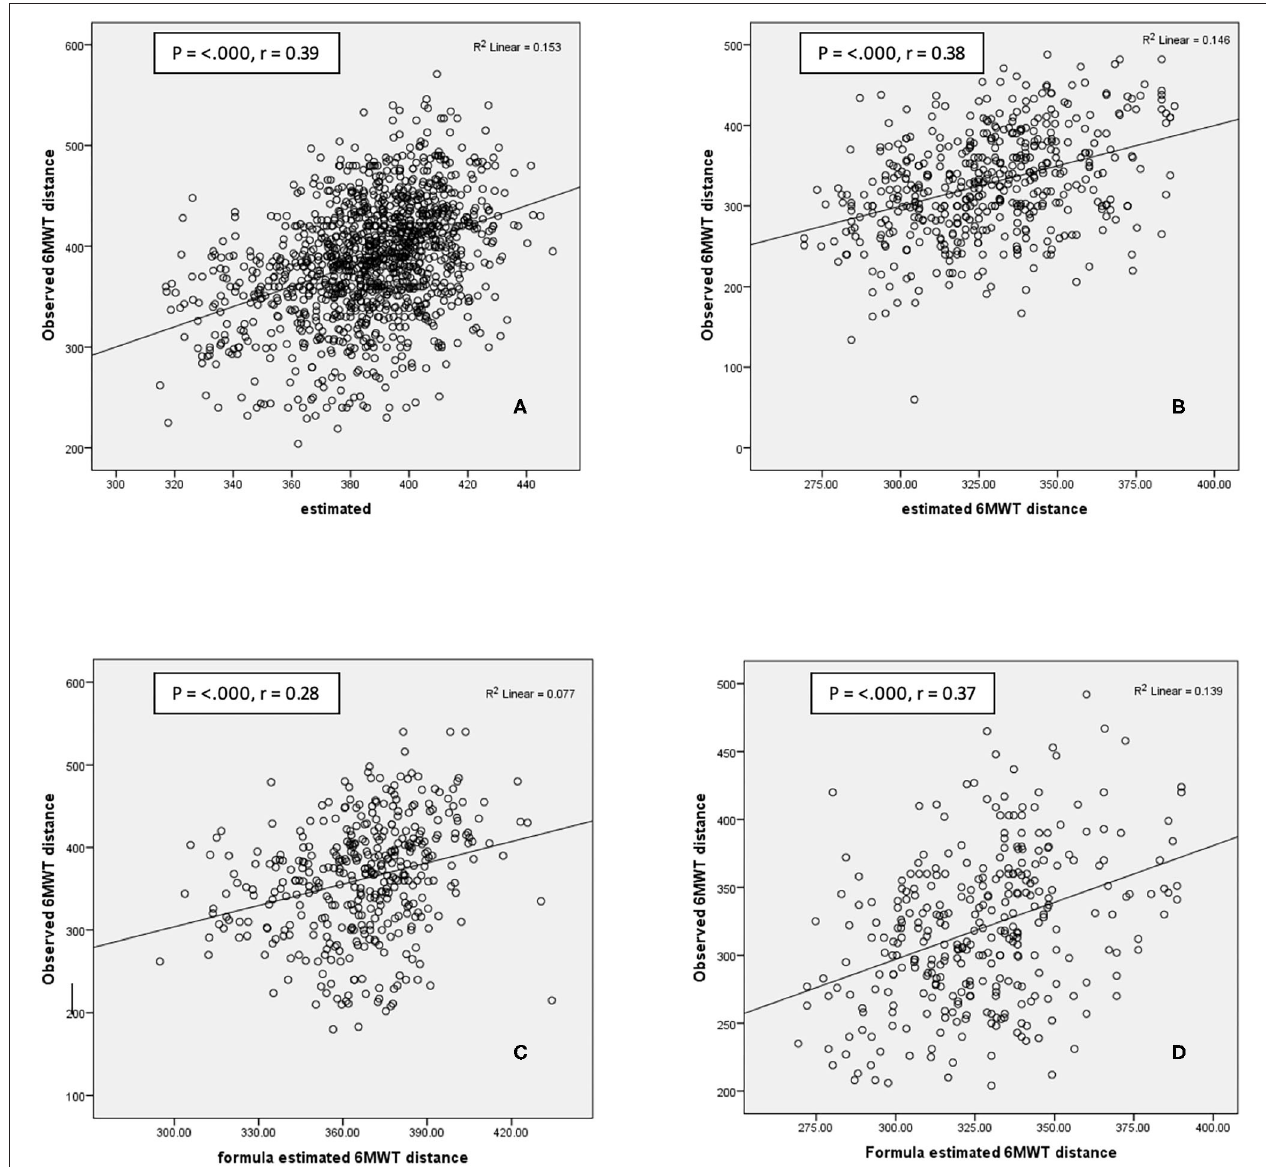
FIGURE 2 | Scatterplot of predicted value with actual 6-MWT. Internal validation: (A) CABG surgery group 2014–2016 population; (B) valve surgery group 2014–2016 population. External validation: (C) . CABG surgery group 2018 population. (D) Valve surgery group 2018 population. p, Pearson correlation significant; r = Pearson coefficient; 6-MWT, 6-min walk test; CABG, coronary artery bypass